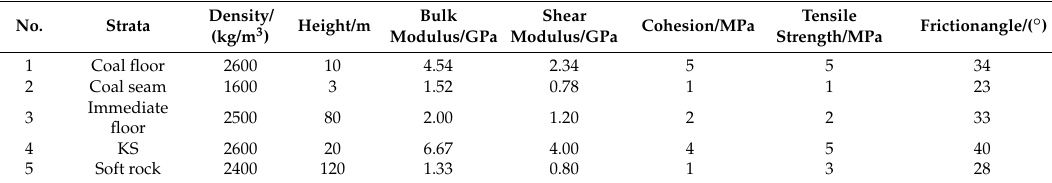
Table 2. Physical and mechanical parameters of basic model.